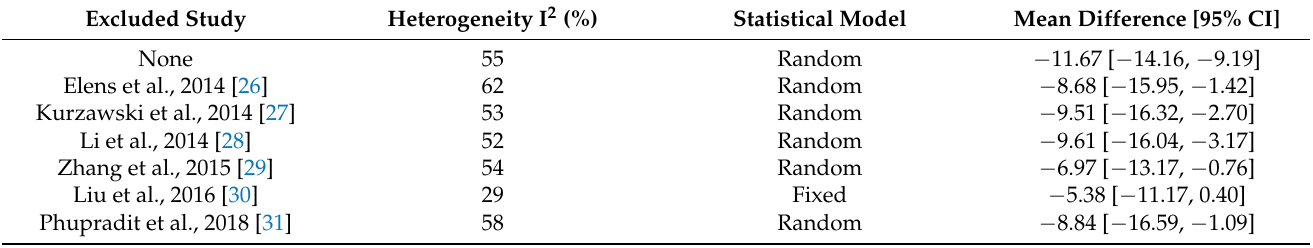
Figure 3. A funnel plot showing the association between POR*28 carriers and standardized trough concentration (ng/mL per mg/kg) of tacrolimus. SE: standard error, MD: mean difference. Table 3. A sensitivity analysis of the association between POR*28 carriers and standardized trough concentration (ng/mL per mg/kg) of tacrolimus by sequentially excluding each study.